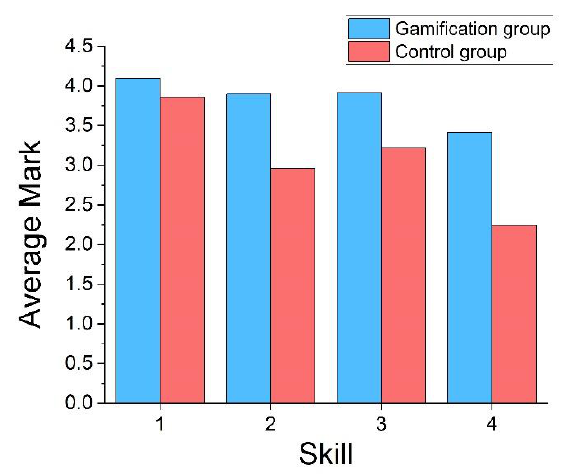
Figure 1. Average Four C’s marks: (1) critical thinking, (2) communication, (3) collaboration, and (4) creativity.